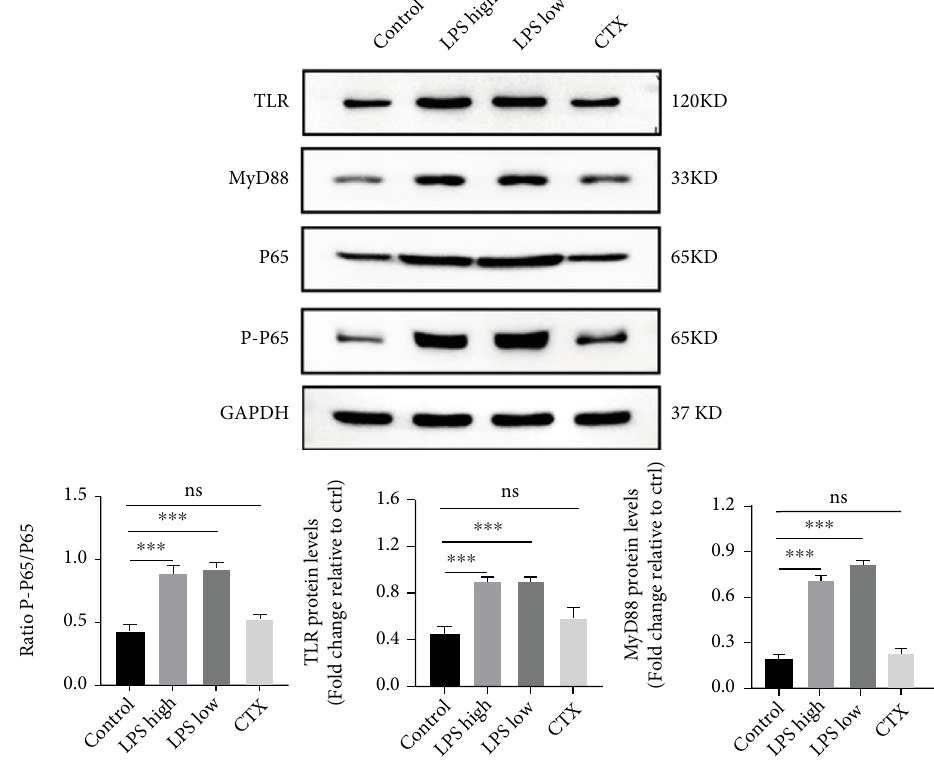
Figure 5: The expression of in fl ammation-related proteins. Western blotting was performed to determine protein expression of TLR, MyD88, p-p65, p-65, and GAPDH in the mouse ovaries. Data are expressed as the mean ± SEM . ∗∗∗ P < 0 : 001 ; ns: nonsigni fi